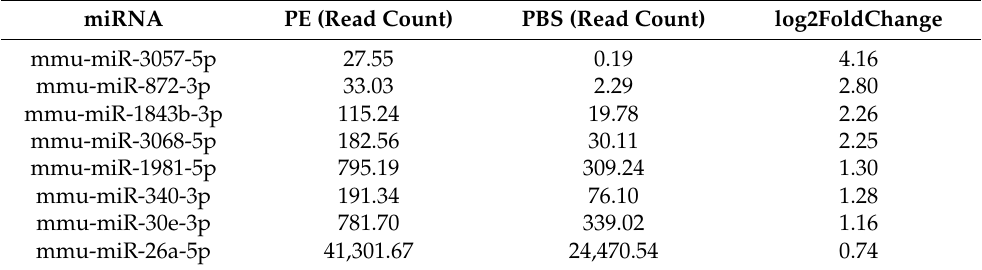
Table 1. miRNAs with significant up-regulation in blood serum extracellular vesicles (EVs) with PE (30 mg/kg/day) infusion for 1 week versus PBS.